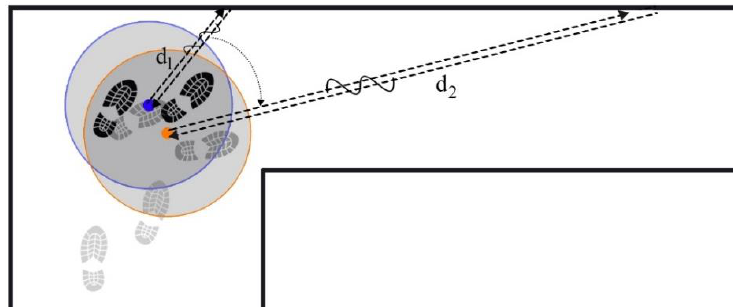
Figure 7. Effect of a significant heading variation in range and, subsequently, velocity measurement of the ToF distance sensor.